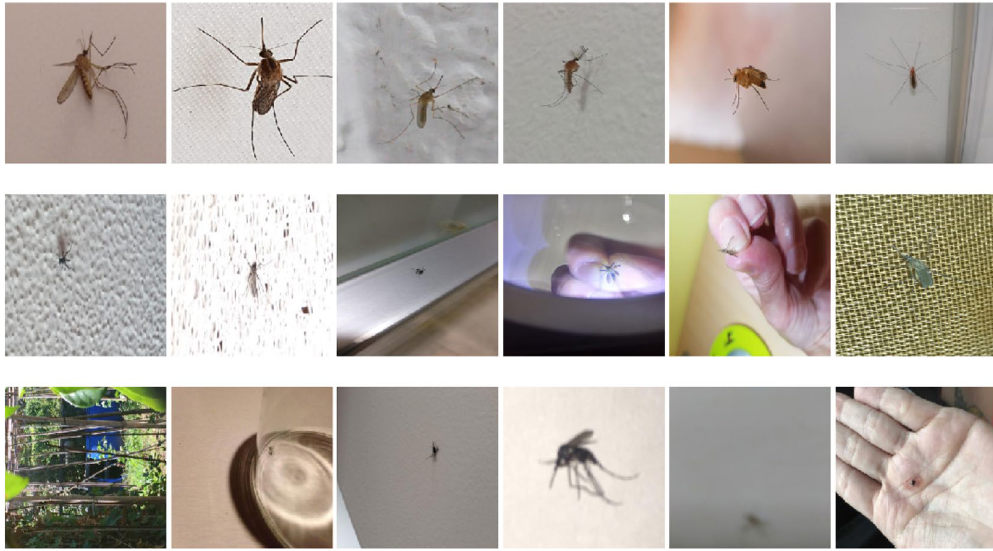
Figure 8. Top row: correctly classified images, where the model was confident, thus assigned close to 1 probability to the correct category. Middle row: examples from the images which were mistakenly predicted by the CNN model. Bottom row: selected examples where the entomology expert could not tell if the presented mosquito is a tiger mosquito or not. The images were resized to have the same aspect ratio for visualization